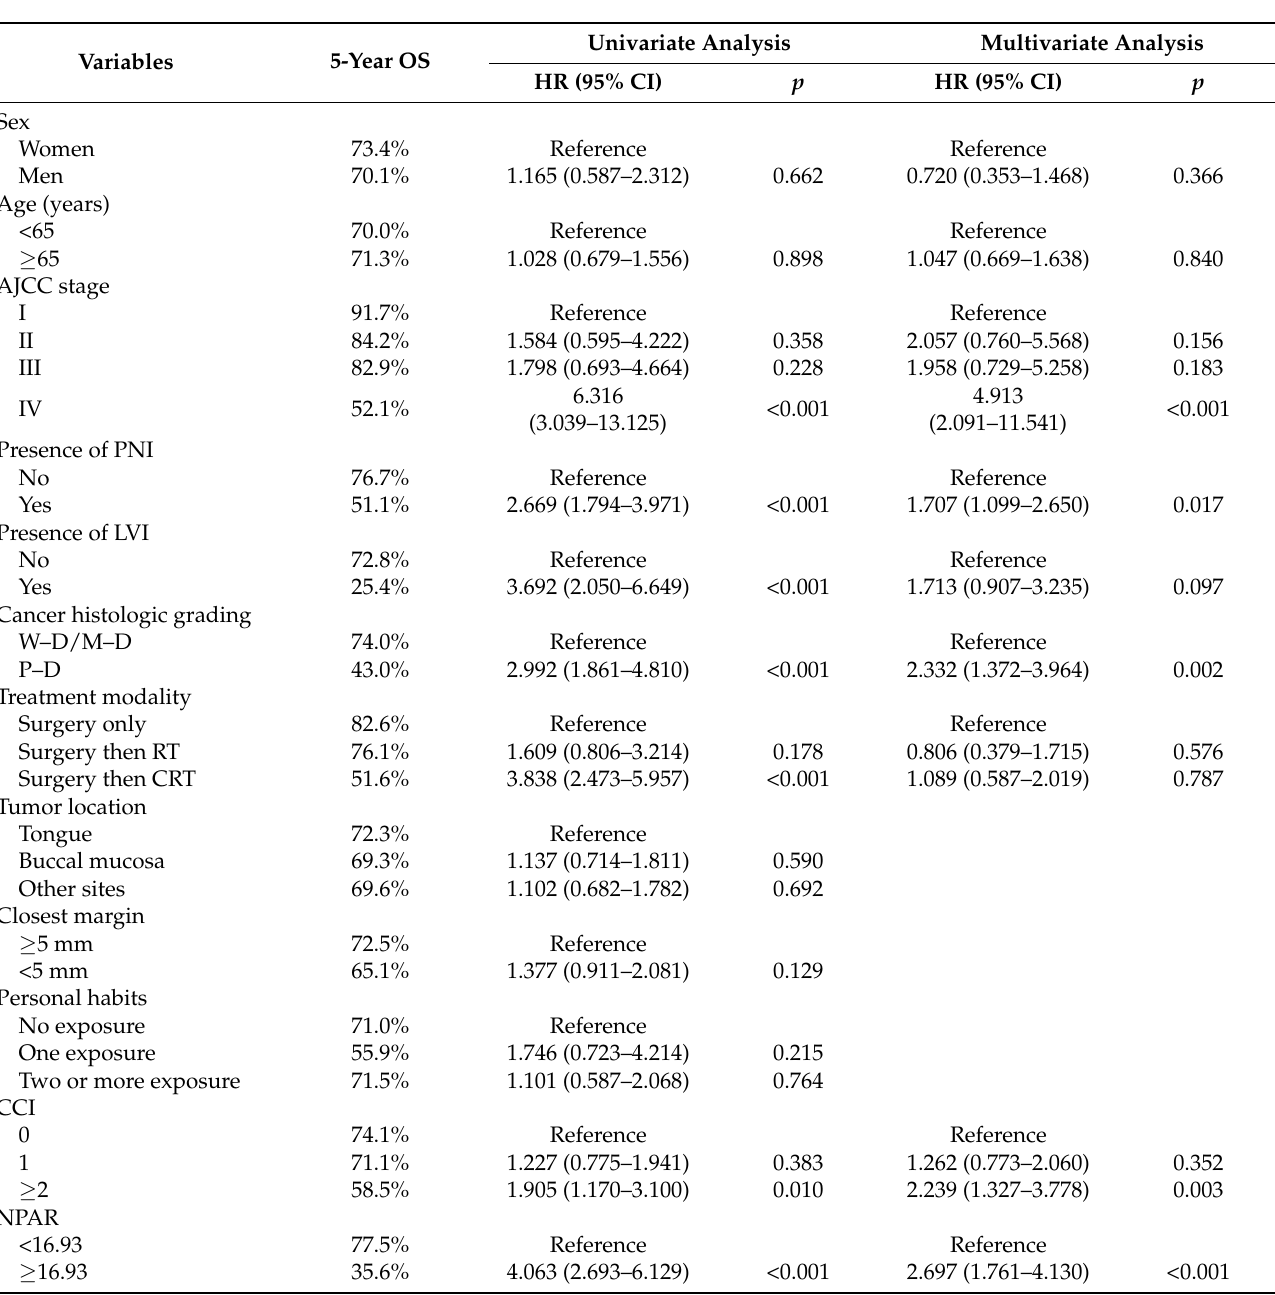
Table 2. Univariate and multivariate analysis of OS of 368 patients with oral cavity squamous cell